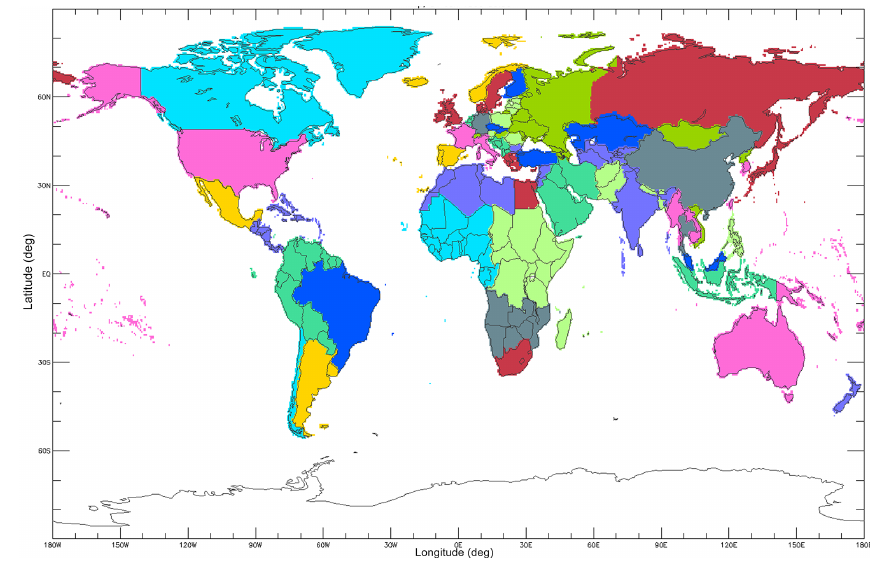
Figure 1. The 56 continental emission source regions in TM5-FASST. See Table S2.2 for the mapping between regions and